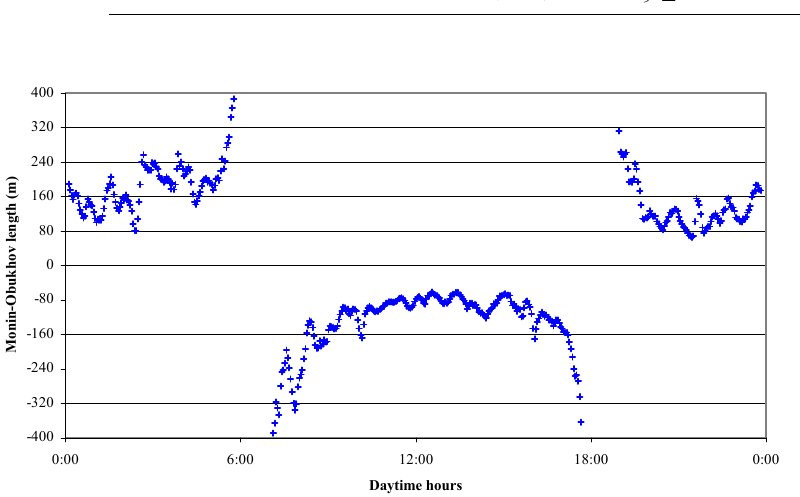
Fig. 3. Variation of the Monin- Obukhov length during the day of 25 July 1997 (Plot